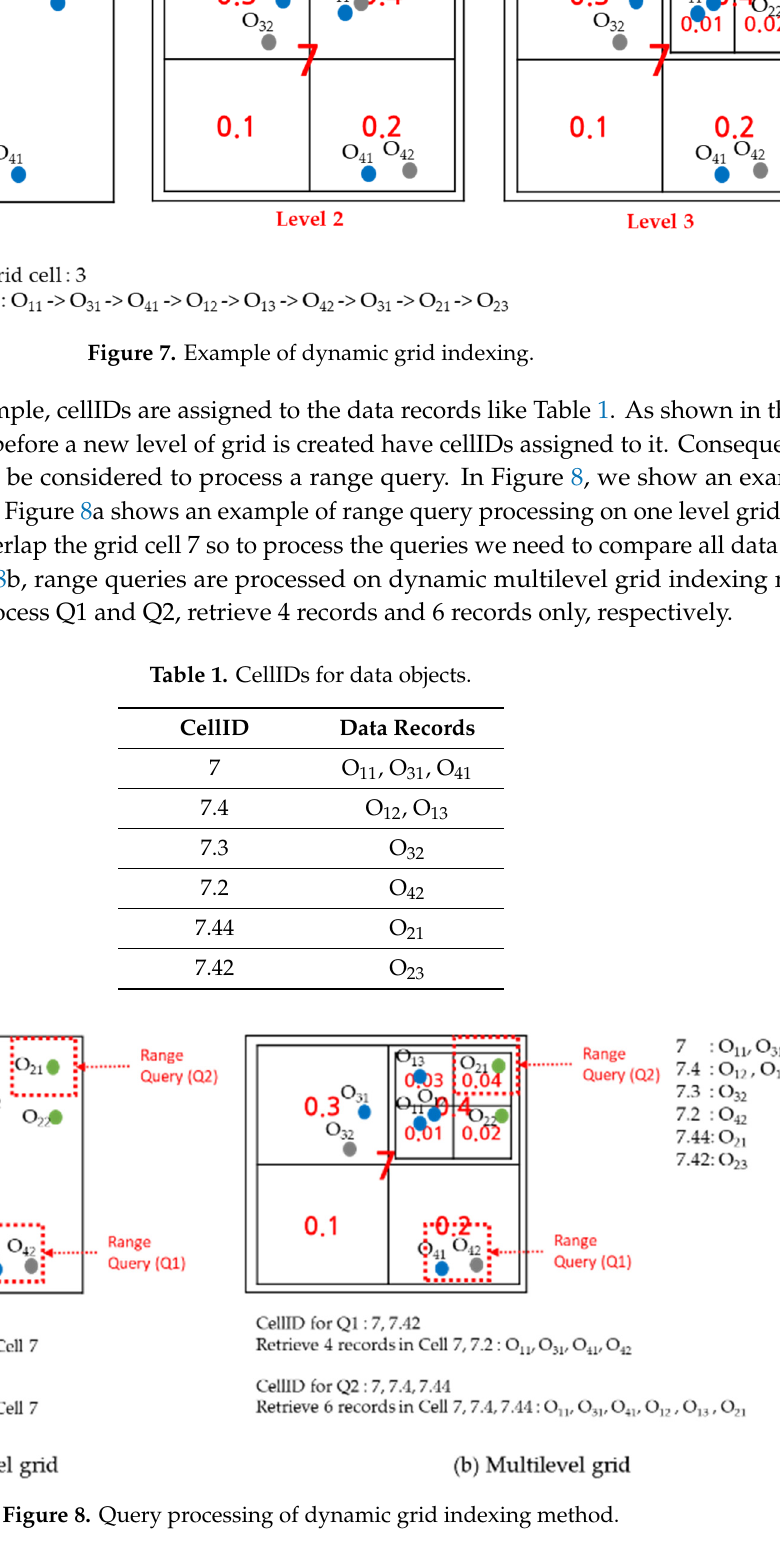
Figure 6. Dynamic grid indexing for skewed data.